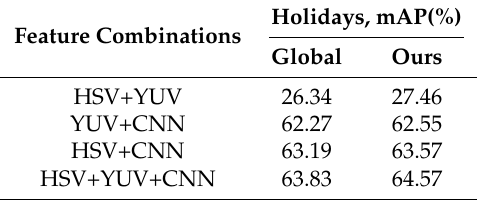
Table 3. Comparison of mAP on Holidays by different parameter